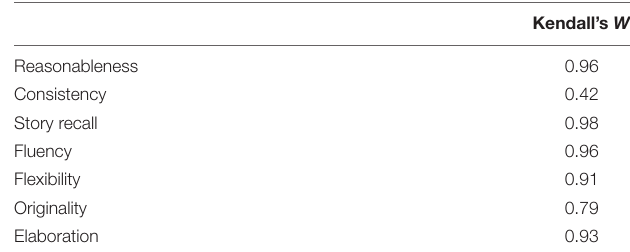
TABLE 1 | Coefficients of concordance among the four raters’ scores of participants’